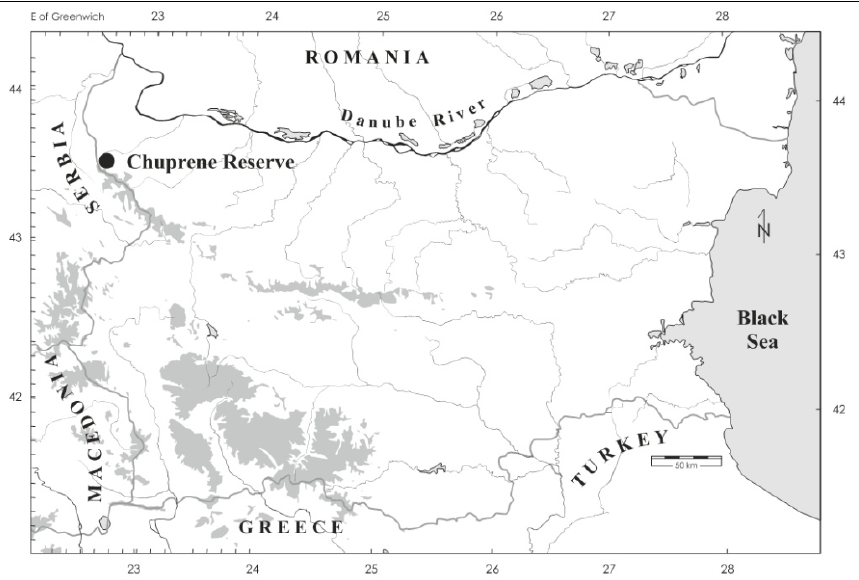
Figure 1. Location of the Chuprene Reserve in Bulgaria.